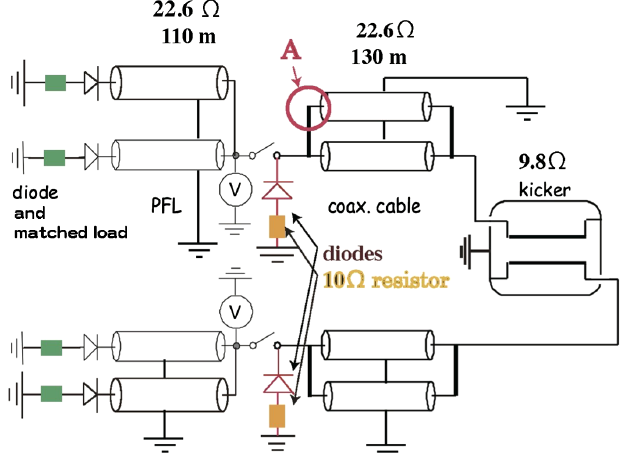
FIG. 4. Measurements of the horizontal beam impedances, where all cables are simply detached from the kicker. The red dashed and blue solid lines show the real and imaginary parts of the impedance.